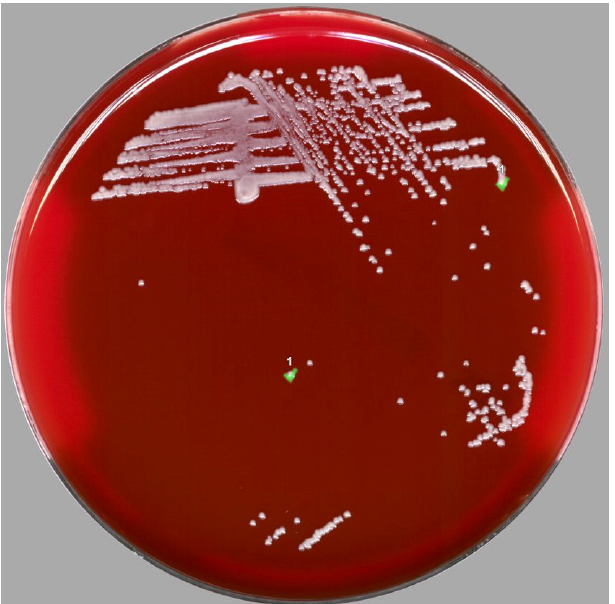
Figure 1. Colonies of Corynebacterium gottingense isolated on blood agar. Subcultured colonies (identified as “1”) could be considered as white (creamy) and were not hemolytic.